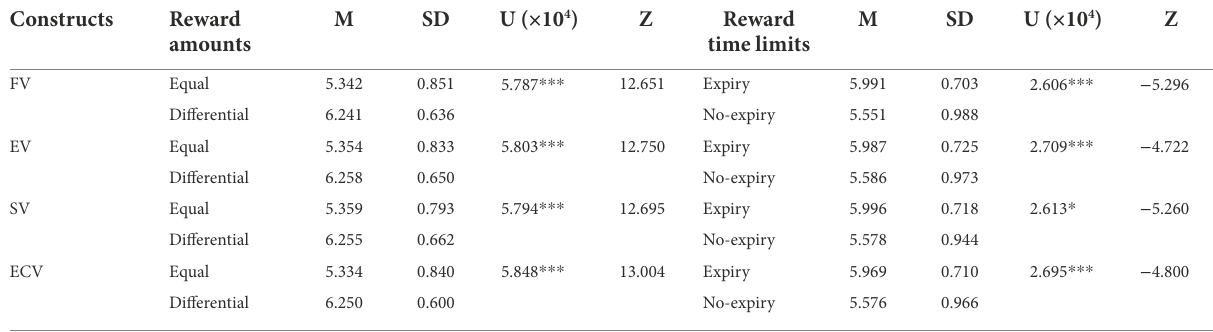
TABLE 6 Non-parametric tests for the effectiveness of LPs with different reward amounts and reward time limits.